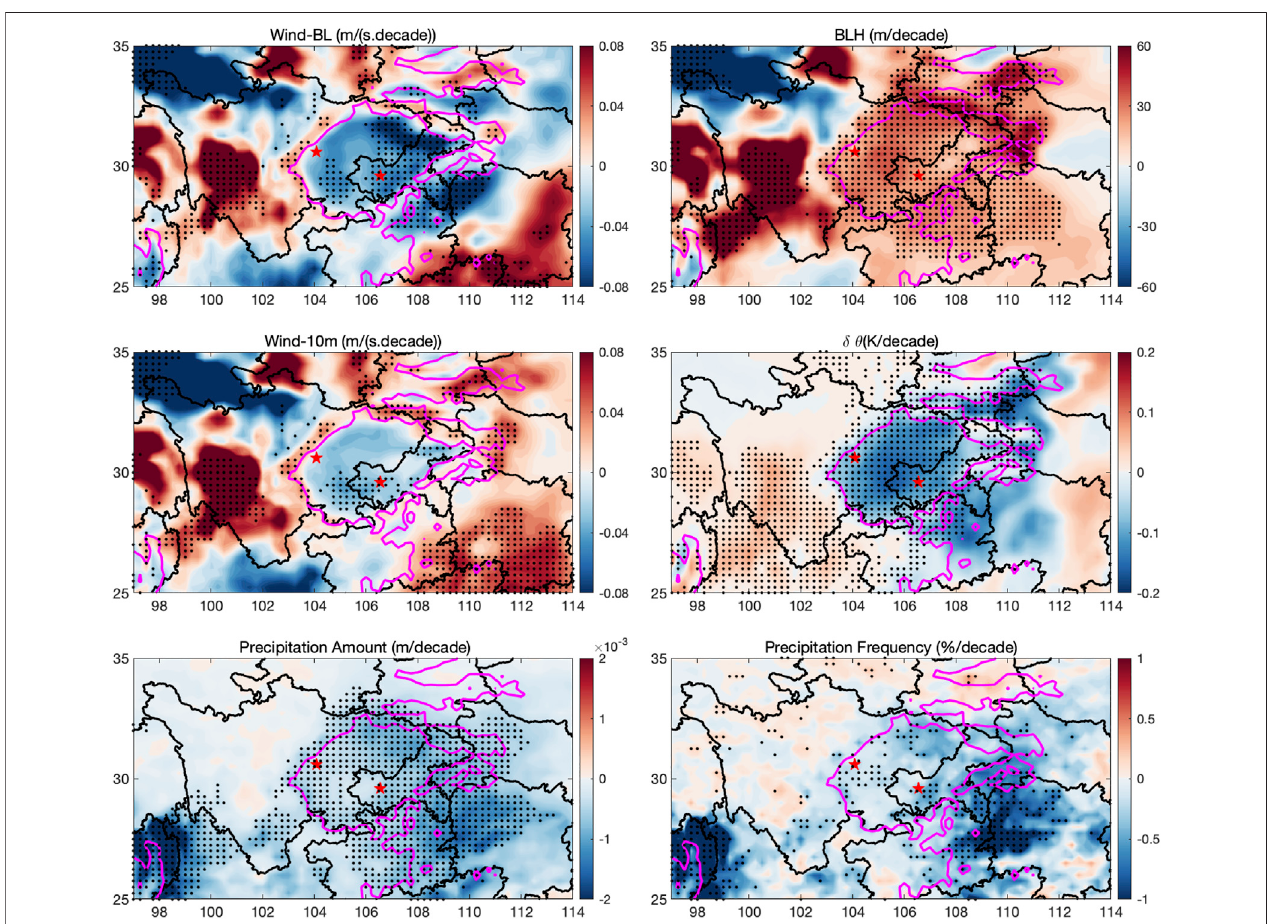
FIGURE 8 | Distribution of the long-term trends of Wind_BL, BLH, Wind_10 m, Δ θ , precipitation amount and precipitation frequency during the winters from 1979 to 2019 in the Sichuan Basin. Dots mark the signi fi cance at 5% of the linear trends based on least square method.